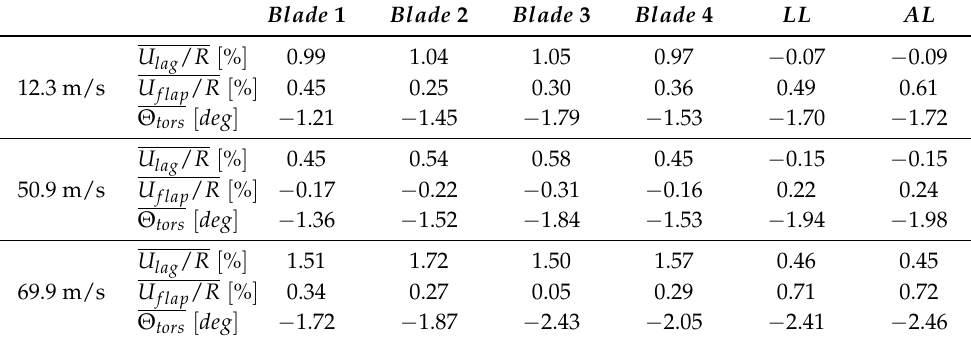
Table 13. Mean values of blade